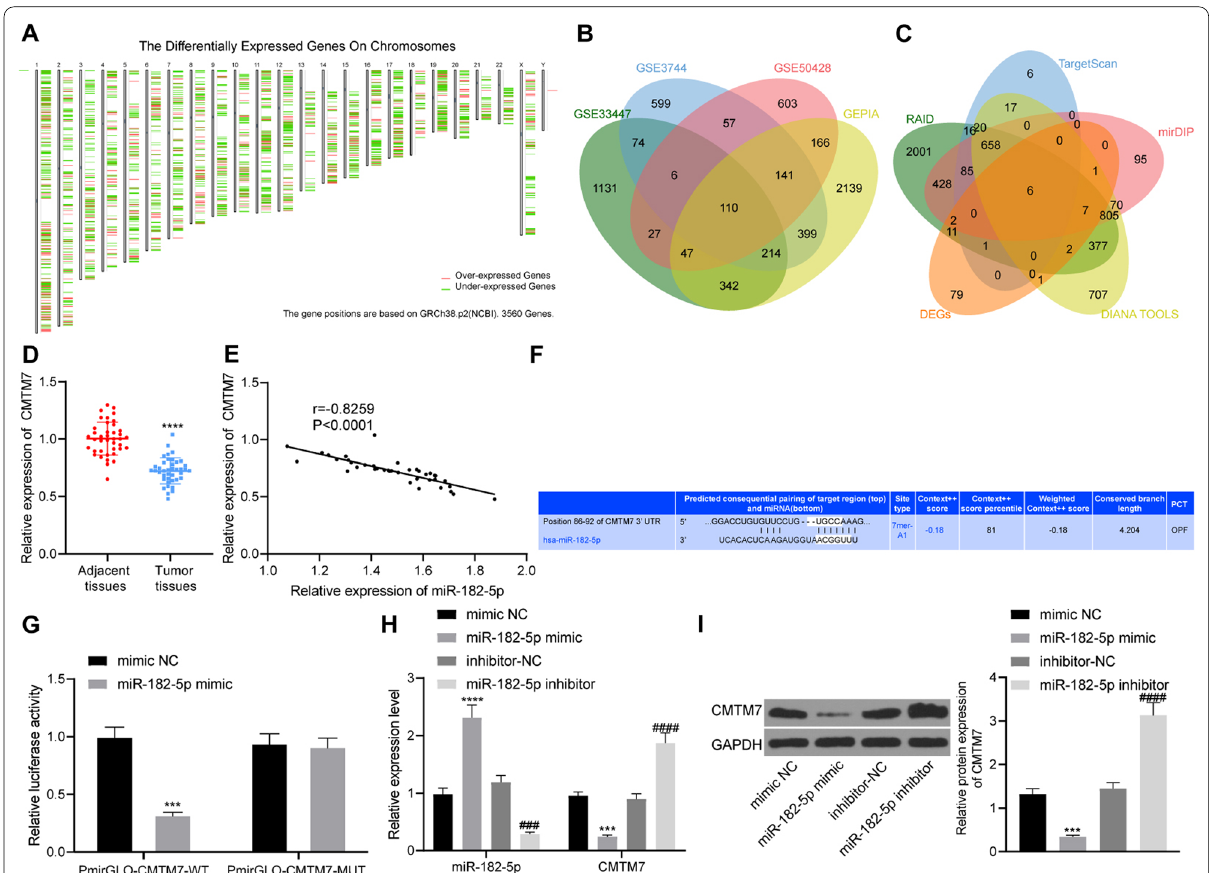
Fig. 5 CMTM7 is a target of miR-182-5p. A A heat map of differential gene expression in breast cancer samples from the TCGA database by GEPIA (from left to right, chromosomes 1–22 and sex chromosomes are present in sequence); B Venn diagram of differential genes screened from datasets GSE33447, GSE3744 and GSE50428 in GEO database and GEPIA; C Venn diagram of miR-182-5p downstream genes and significantly differential genes predicted by RAID, TargetScan, mirDIP and DIANA TOOLS databases; D CMTM7 expression in cancer tissues and adjacent normal tissues of 40 breast cancer patients detected by RT-qPCR, he statistical power was 1; E Pearson correlation analysis of the expression of miR-182-5p and CMTM7 in breast cancer tissues, the statistical power was 0.999; F Binding site between miR-182-5p and CMTM7 predicted by the TargetScan website; G Binding of miR-182-5p to CMTM7 confirmed by dual luciferase experiment, the statistical power was 1; H Expression of miR-182-5p and CMTM7 of HUVECs detected by RT-qPCR, the statistical power was 1; I Expression of CMTM7 protein of HUVECs detected by Western blot analysis, the statistical power was 1. *** p < 0.001, **** p < 0.0001 compared with adjacent normal tissues, or HUVECs treated with mimic NC. ### p < 0.001, #### p < 0.0001 compared with HUVECs treated with inhibitor NC. The experiment was conducted three times independently